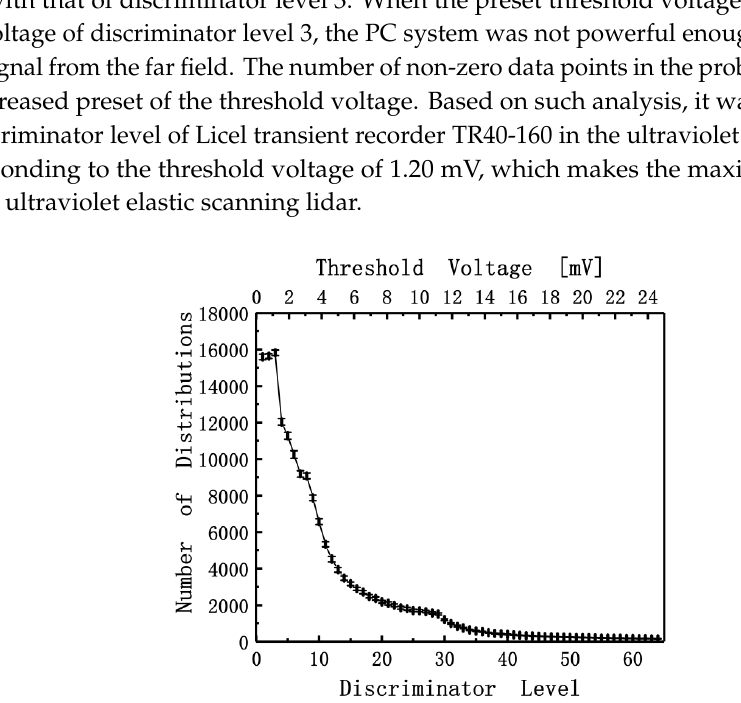
Figure 7. ( a ) Probing profiles of photon-counting data with different settings of threshold voltage at the same atmospheric conditions and ( b ) their corresponding statistics of the non-zero distributions.